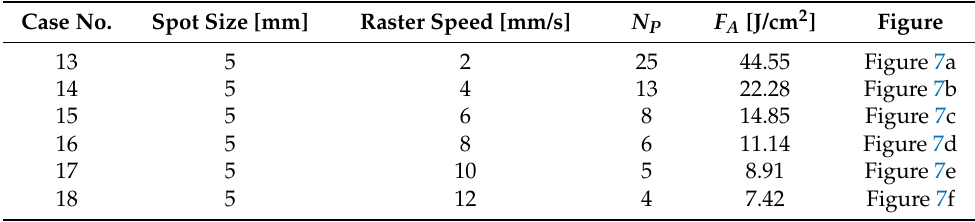
* F A = N P · F 1 for spot-by-spot. Table A2. Laser processing parameters for the laser raster method (average power 3.5 W). Case